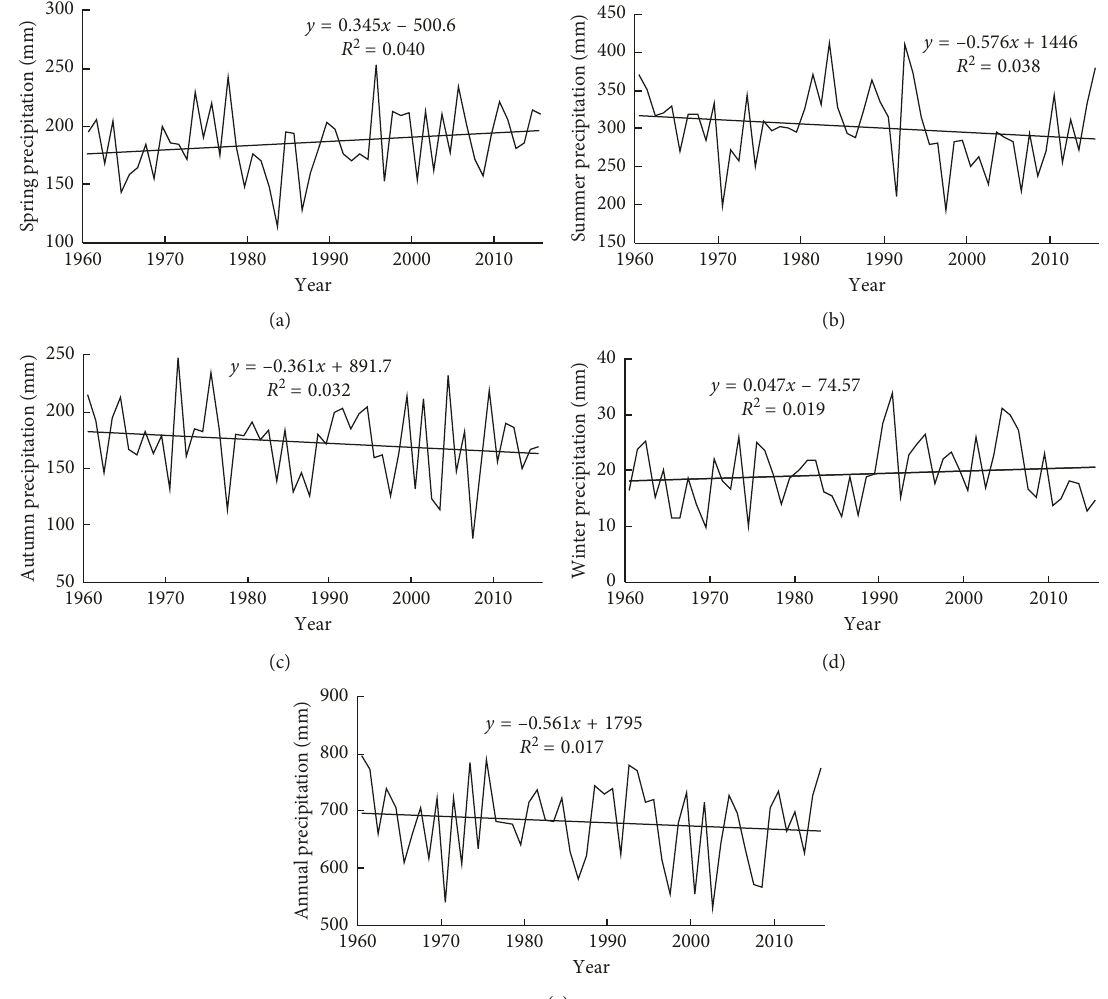
Figure 5: Trends of study area for seasonal and annual precipitation by liner regression method.